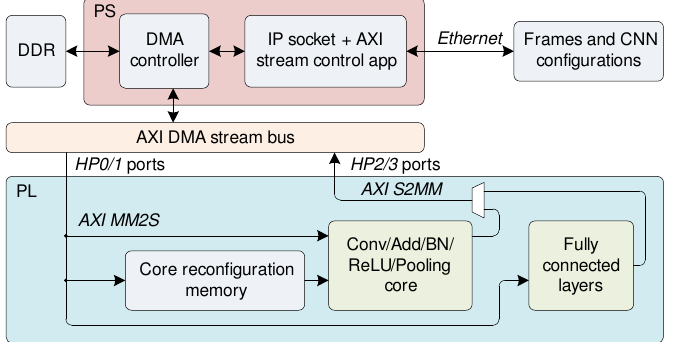
Figure 8. The diagram of data transfer between the processing system (PS) and the PL using the AXI DMA stream